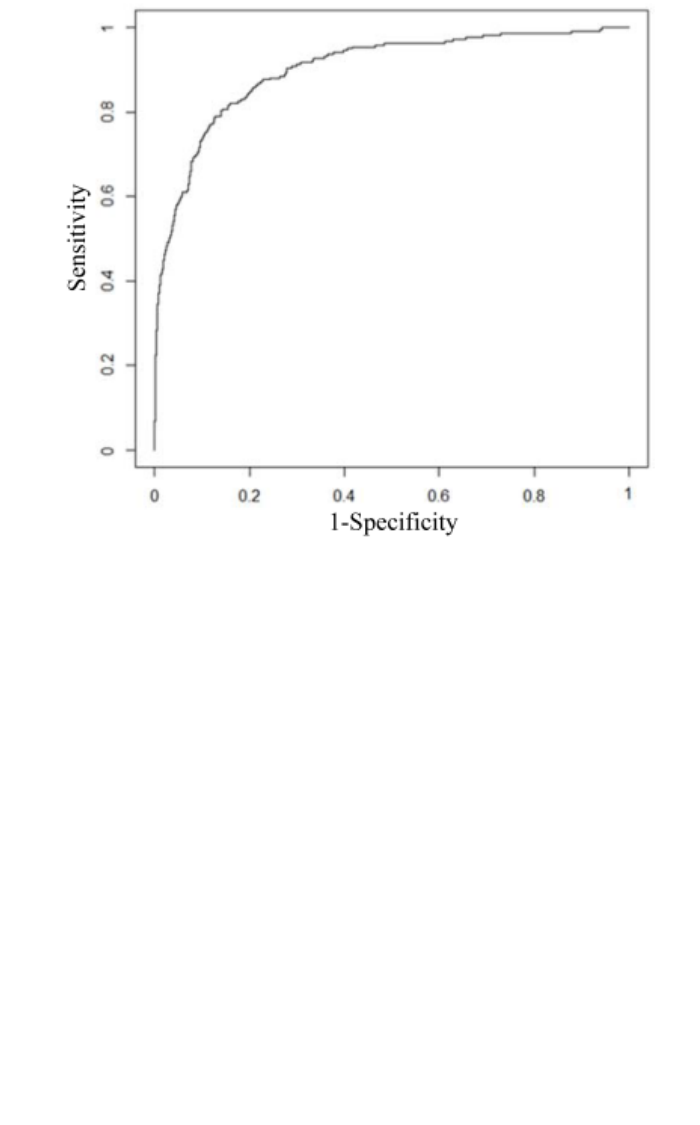
Figure 2. The receiver operating characteristic curve of our final University of Washington Medicine